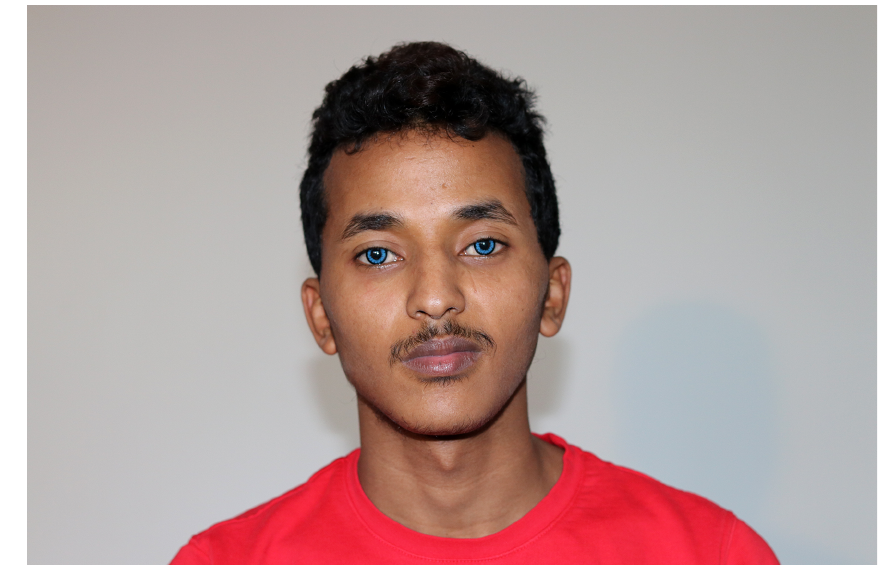
Figure 19. Shirak wearing his new blue contact lenses. March 2017.